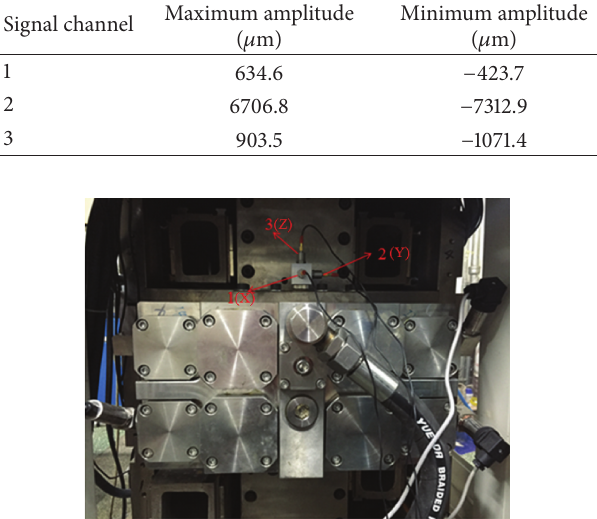
Figure 8: Vibration test